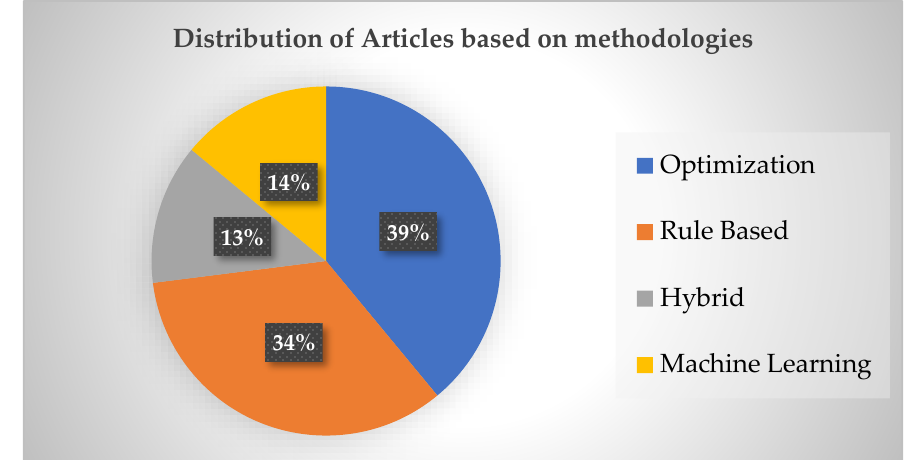
Figure 6. Article distribution depending on the methodology.